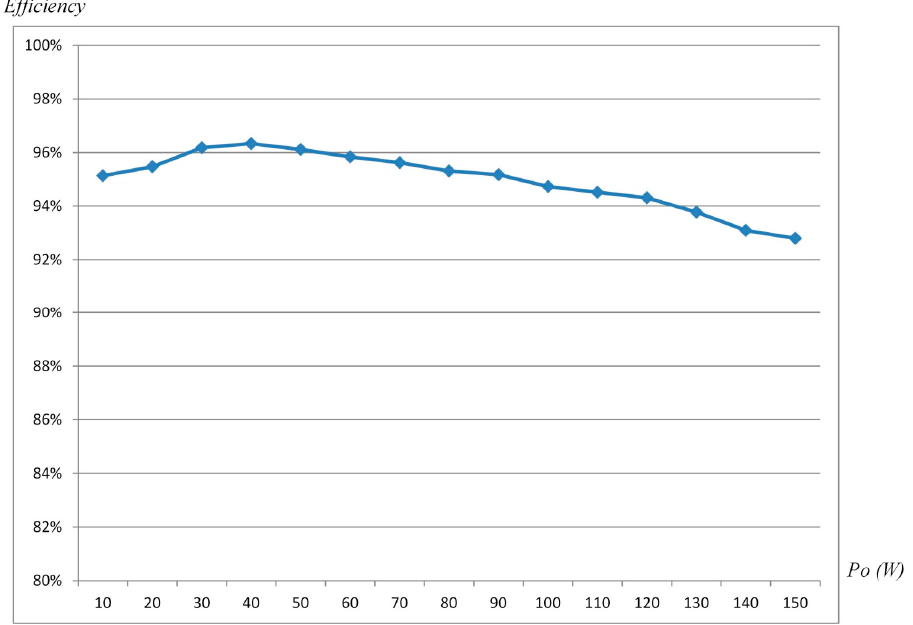
Figure 11. Efficiency of proposed converter.